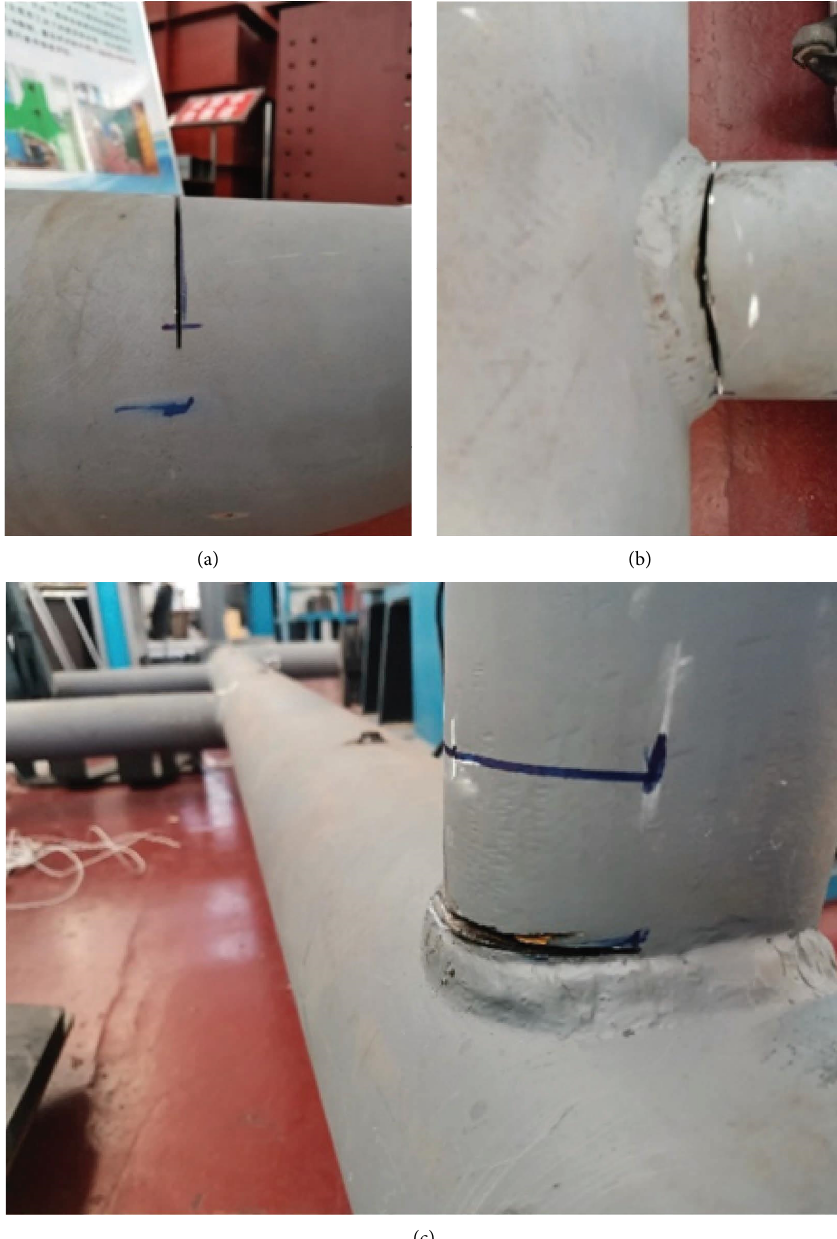
Figure 6: Pipe model with cracks: (a) large pipe elbow, (b) pipe connection with a mass block, and (c) vertical bent pipe connection. Table 1: Test models of diferent crack locations.